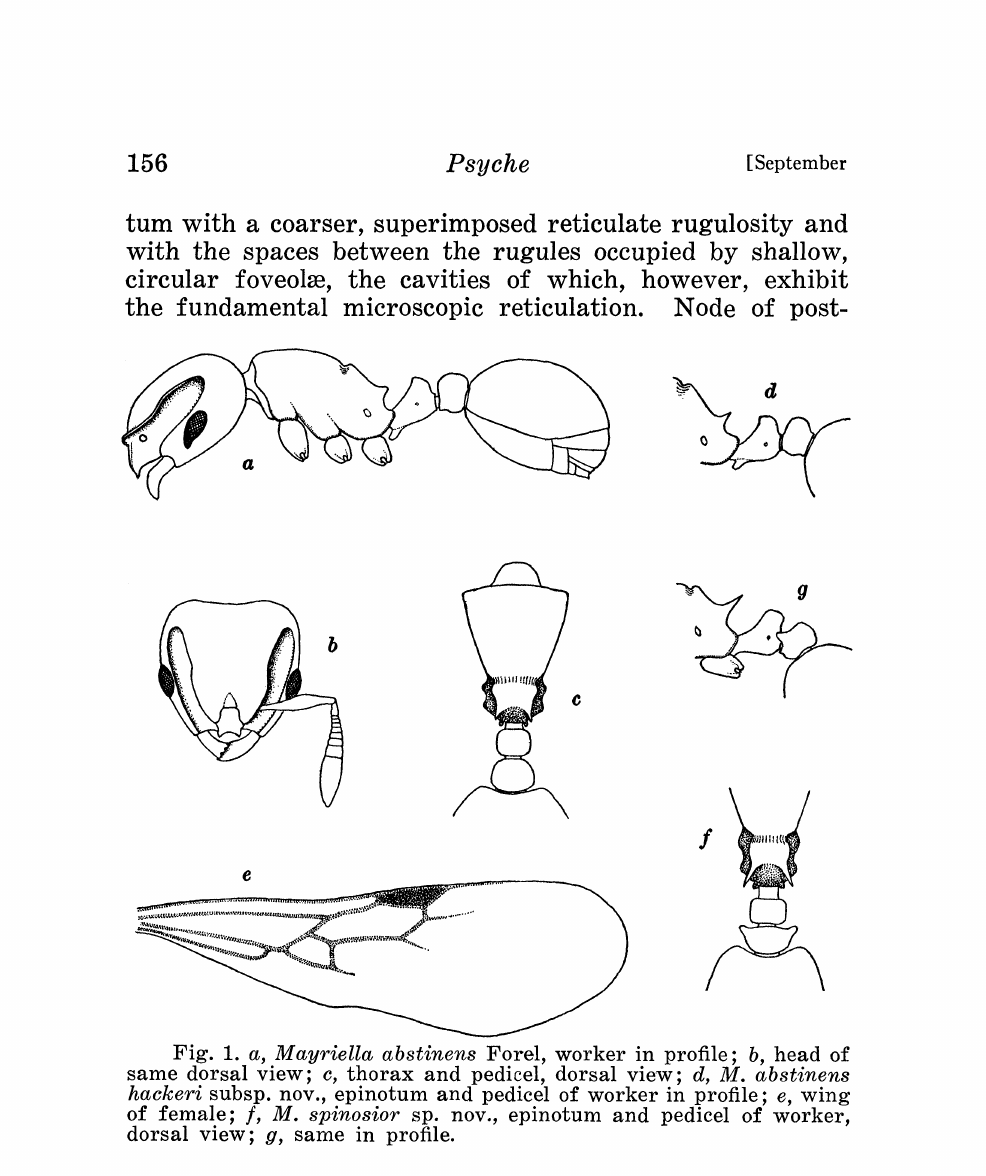
Fig. 1. a, Mayriella abstinens Forel, worker in profile; b, head of same dorsal view; c, thorax and pedicel, dorsal view; d, M. abstinens hackeri subsp, nov., epinotum and pedicel of worker in profile; e, wing of female; ], M. spinosior sp. nov., epinotum and pedicel of worker, dorsal view; g, same in